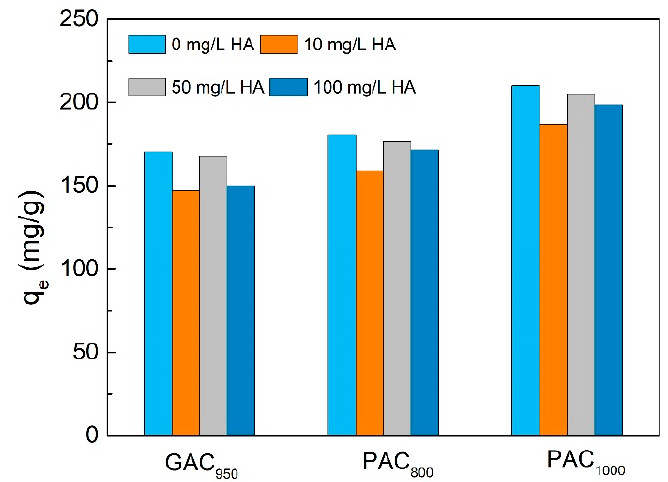
Figure 10. Effect of humic acid (HA) concentration on phenol adsorption onto AC.